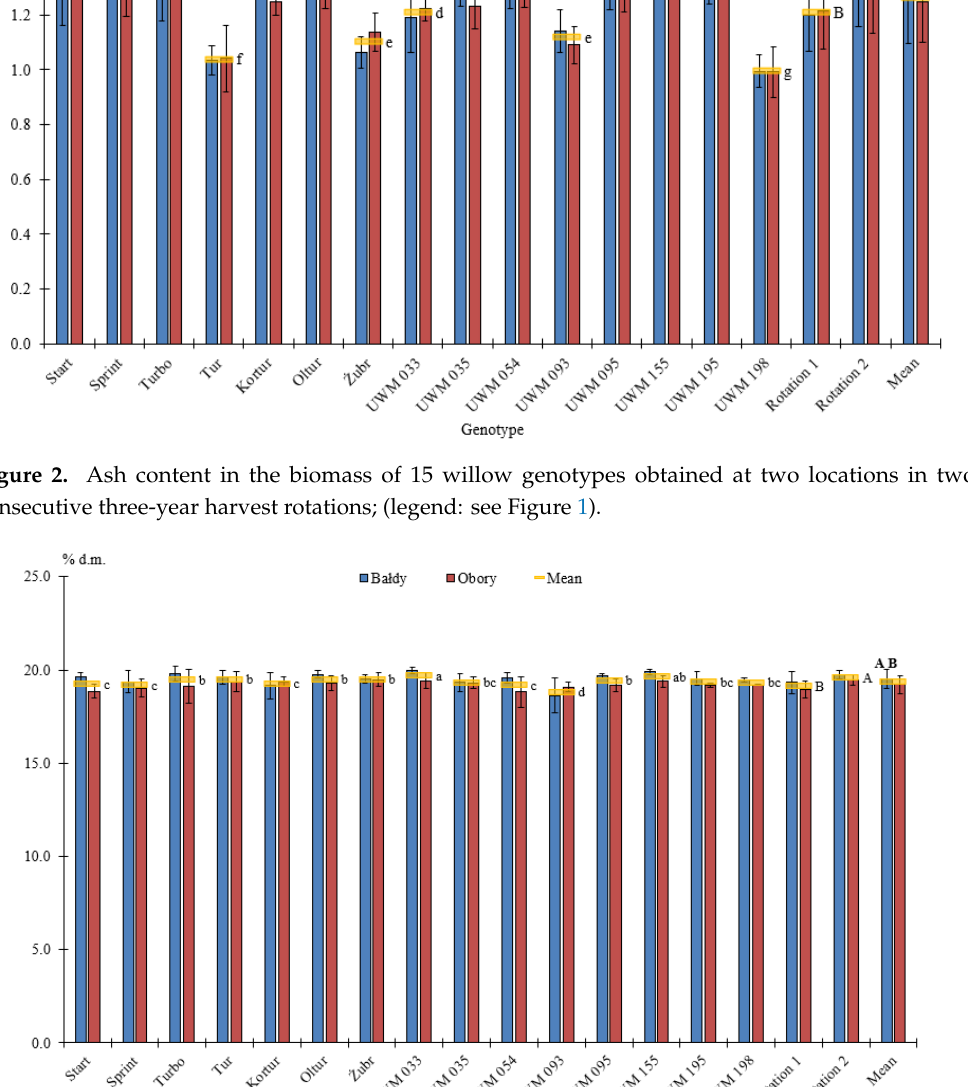
Figure 4. Volatile matter content in the biomass of 15 willow genotypes obtained at two locations in two consecutive three-year harvest rotations; (legend see Figure 1). The analyses showed that HHV was determined to the greatest extent by location (49%), which was rather surprising. However, it appeared that the genotype (20%) also had a significant impact on this characteristic (Table 1). Different relationships were also observed in the case of the LHV, as this characteristic was found to be determined by the genotype to the greatest extent (75%), while the location determined it only by 8%. The mean HHV throughout the experiment was 19.53 MJ kg − 1 d.m., regardless of the location, genotype or harvest rotation. (Figure 5). The mean value of this characteristic for Ba ł dy was 19.68 MJ kg − 1 d.m. and it was higher than at Obory by 0.3 MJ kg − 1 d.m. Among the genotypes under study, the highest HHV was determined for the biomass of the UWM 093 clone of S. acutifolia (mean 19.79 MJ kg − 1 d.m.). It was lower by approx. 2% in the Ż ubr cultivar of